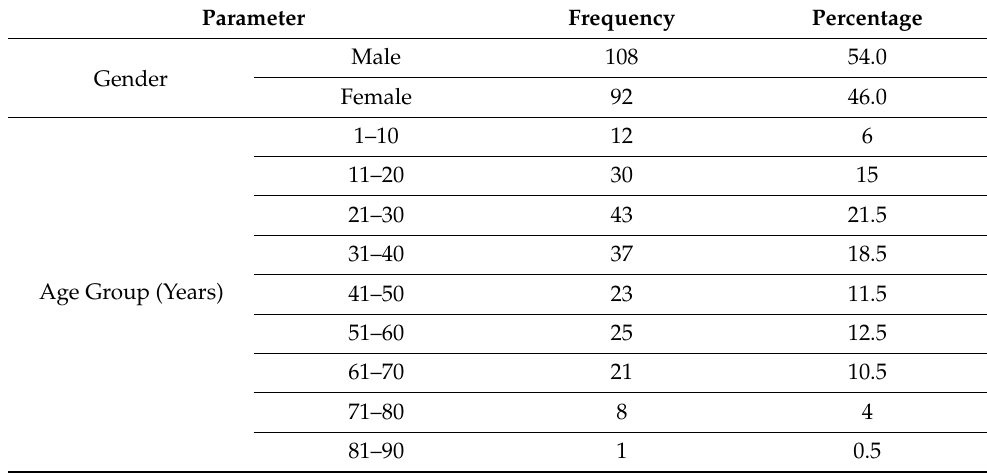
Table 4. Frequency of patients’ gender and